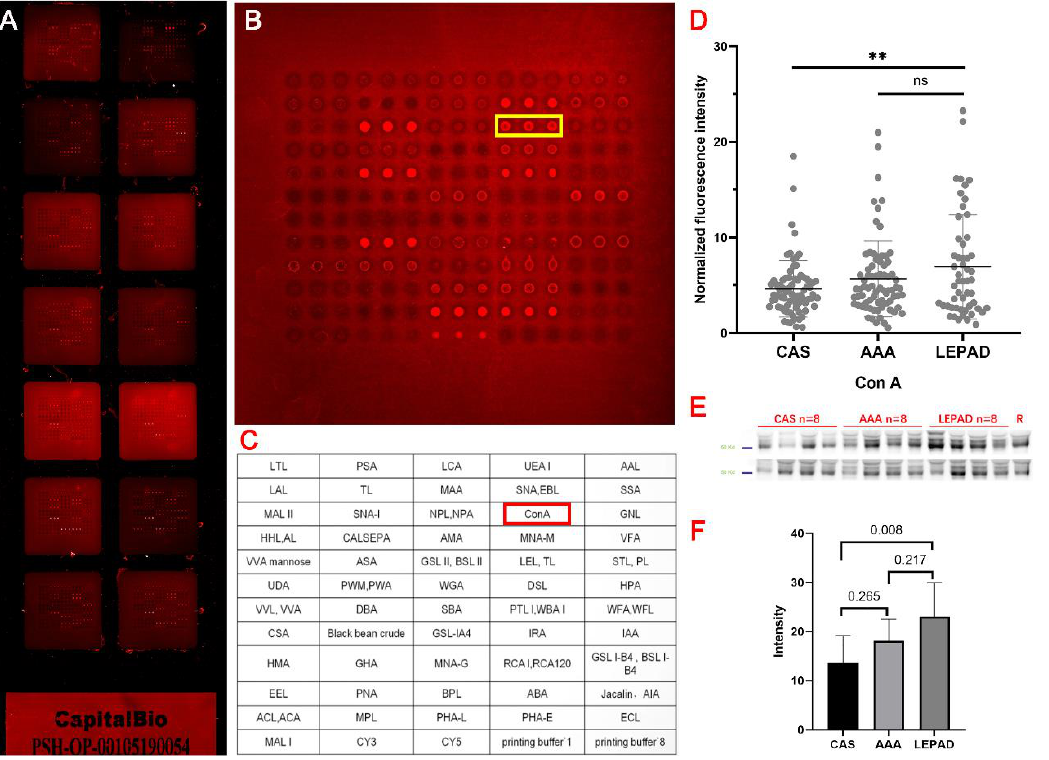
Figure 1. Example of lectin experimental procedure. ( A ) Each lectin microarray has 14 loading wells for 14 serum samples. ( B , C ) Each loading well contains 56 lectins and florescent or buffer controls with 3 iterations. Yellow box and red box indicate the position of lectin Con A. ( D ) Average normalized B/F signals of every lectin for each subject were calculated and compared within disease groups or subgroups. ** p < 0001; ns: p > 0.05. ( E ) A small cohort of serum was randomly selected for lectin blot verification. The IgG bands located at around 55kd on SDS-PAGE. ( F ). Lectin blot signal was analyzed and compared with lectin microarray results.